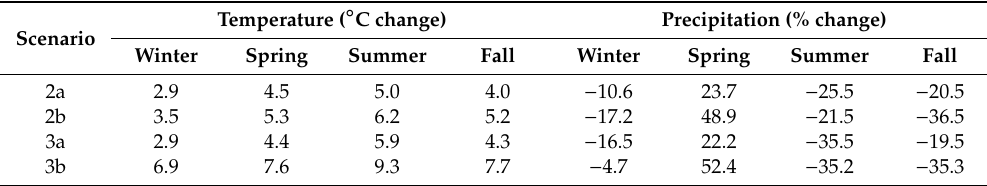
Table 2. Average seasonal changes in mean temperature and precipitation in the territory of Minija River basin for the climate change